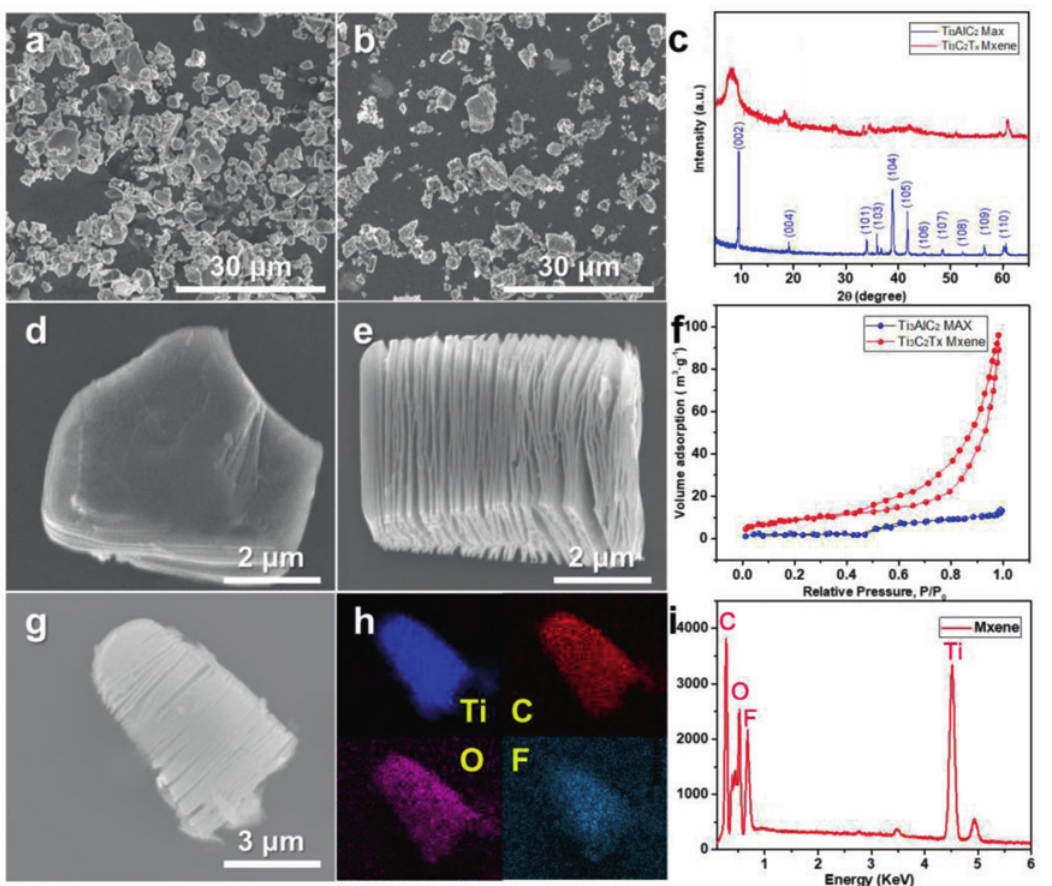
Figure 2: (a, d) SEM images of Ti 3 AlC 2 MAX. (b, e, g) SEM images of Ti 3 C 2 T x Mxene. (c) XRD patterns of Ti 3 AlC 2 MAX and Ti 3 C 2 T x Mxene. (f) Nitrogen adsorption-desorption isotherms of Ti 3 AlC 2 MAX and Ti 3 C 2 T x Mxene. (h) Element mappings of Ti 3 C 2 T x : Ti, C, O, F. (i) EDX spectrum of Ti 3 C 2 T x